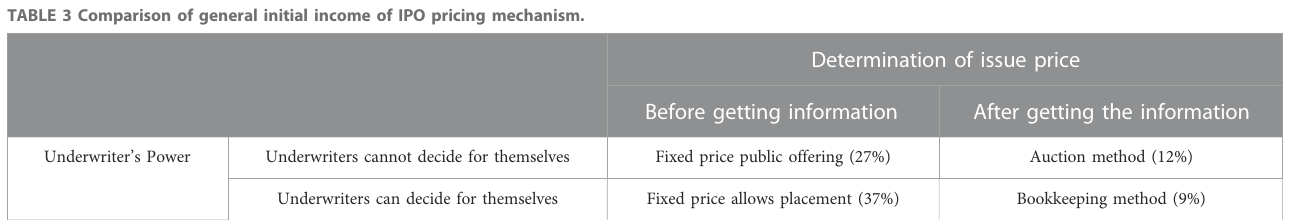
Auction mechanism